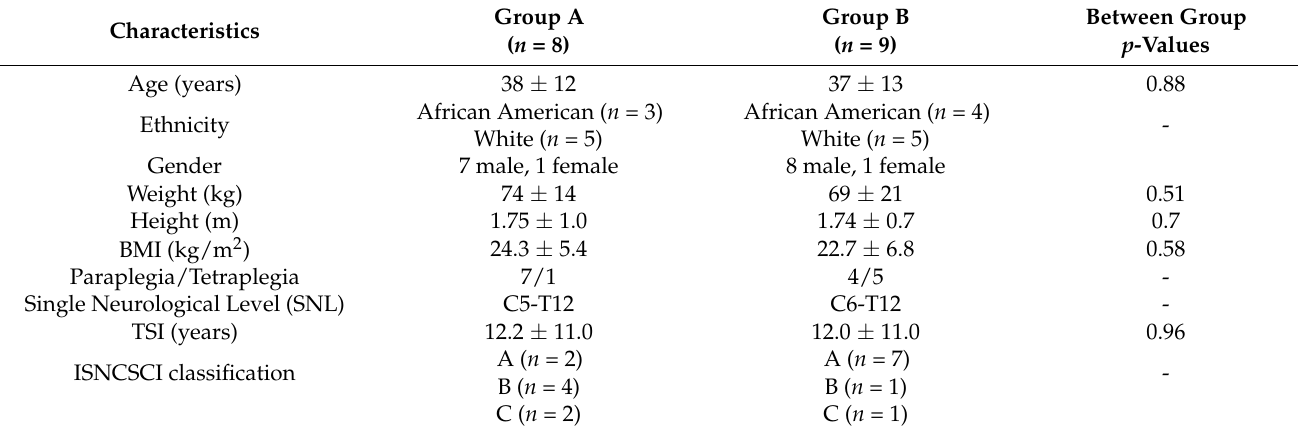
Table 1. Physical and SCI characteristics of the participants at the time of admission who were classified according to the amplitude of the current and repetitions into greater (group A) and lower (group B) musculoskeletal qualities. Values are presented as mean ± standard deviation